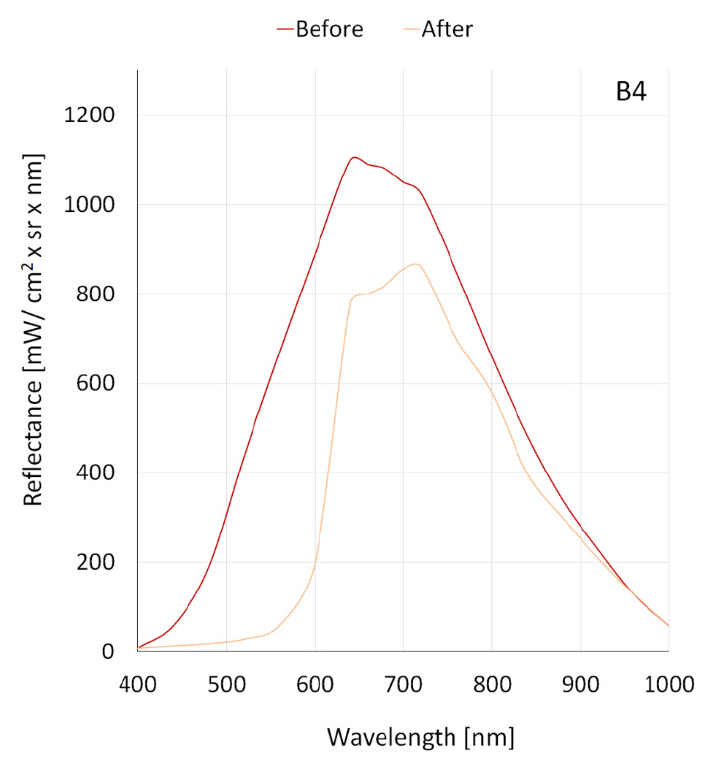
Figure 9. The correlation between the reflectance and the wavelength for the B4 dye before and after